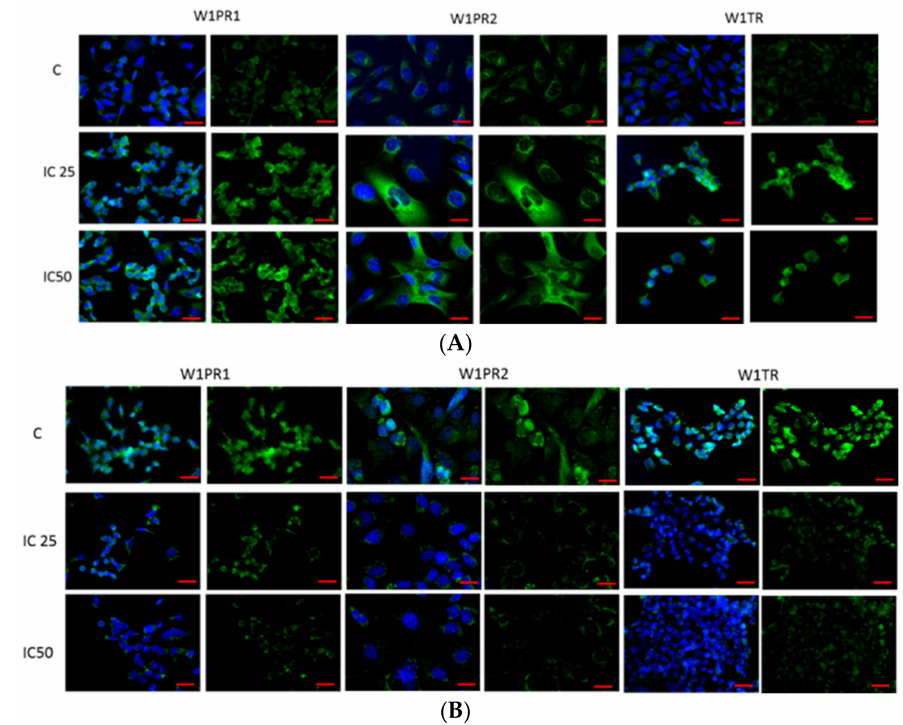
Figure 3. Immunofluorescence visualization of PTPRK ( A ) and pTyr ( B ) expression in PAC and TOP- resistant cell lines after piperine treatment. PTPRK was detected using the anti-PTPRK antibody and an Alexa Fluor ® 488-conjugated secondary antibody (green). pTyr was detected using the anti-pTyr antibody and MFP488-conjugated secondary antibody (green). Cell nuclei were stained with DAPI (blue). Row C shows the control state (cells without piperine), IC25 and IC50 show the cells treated with piperine for 72 h. The first column shows both DAPI (blue) and target protein signal (green), the second column shows the target protein signal alone. Scale bar = 2- µ